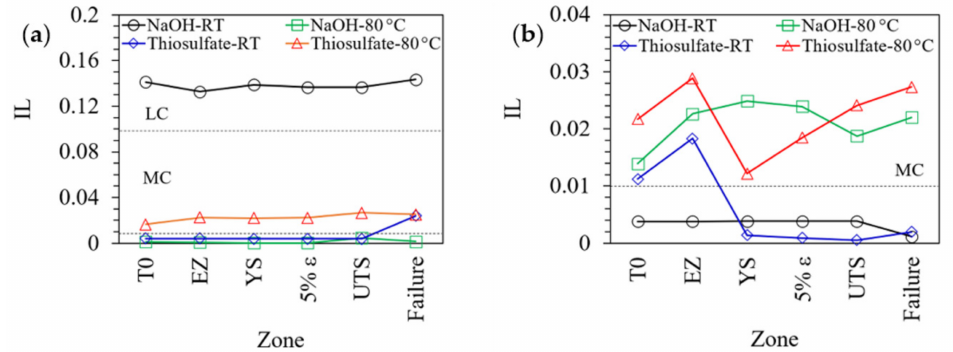
Figure 14. The change in the LI through different conditions for the ( a ) ERNiCrMo-3 weld and ( b ) ER310 weld. LC: Localized corrosion, MC: Mixed